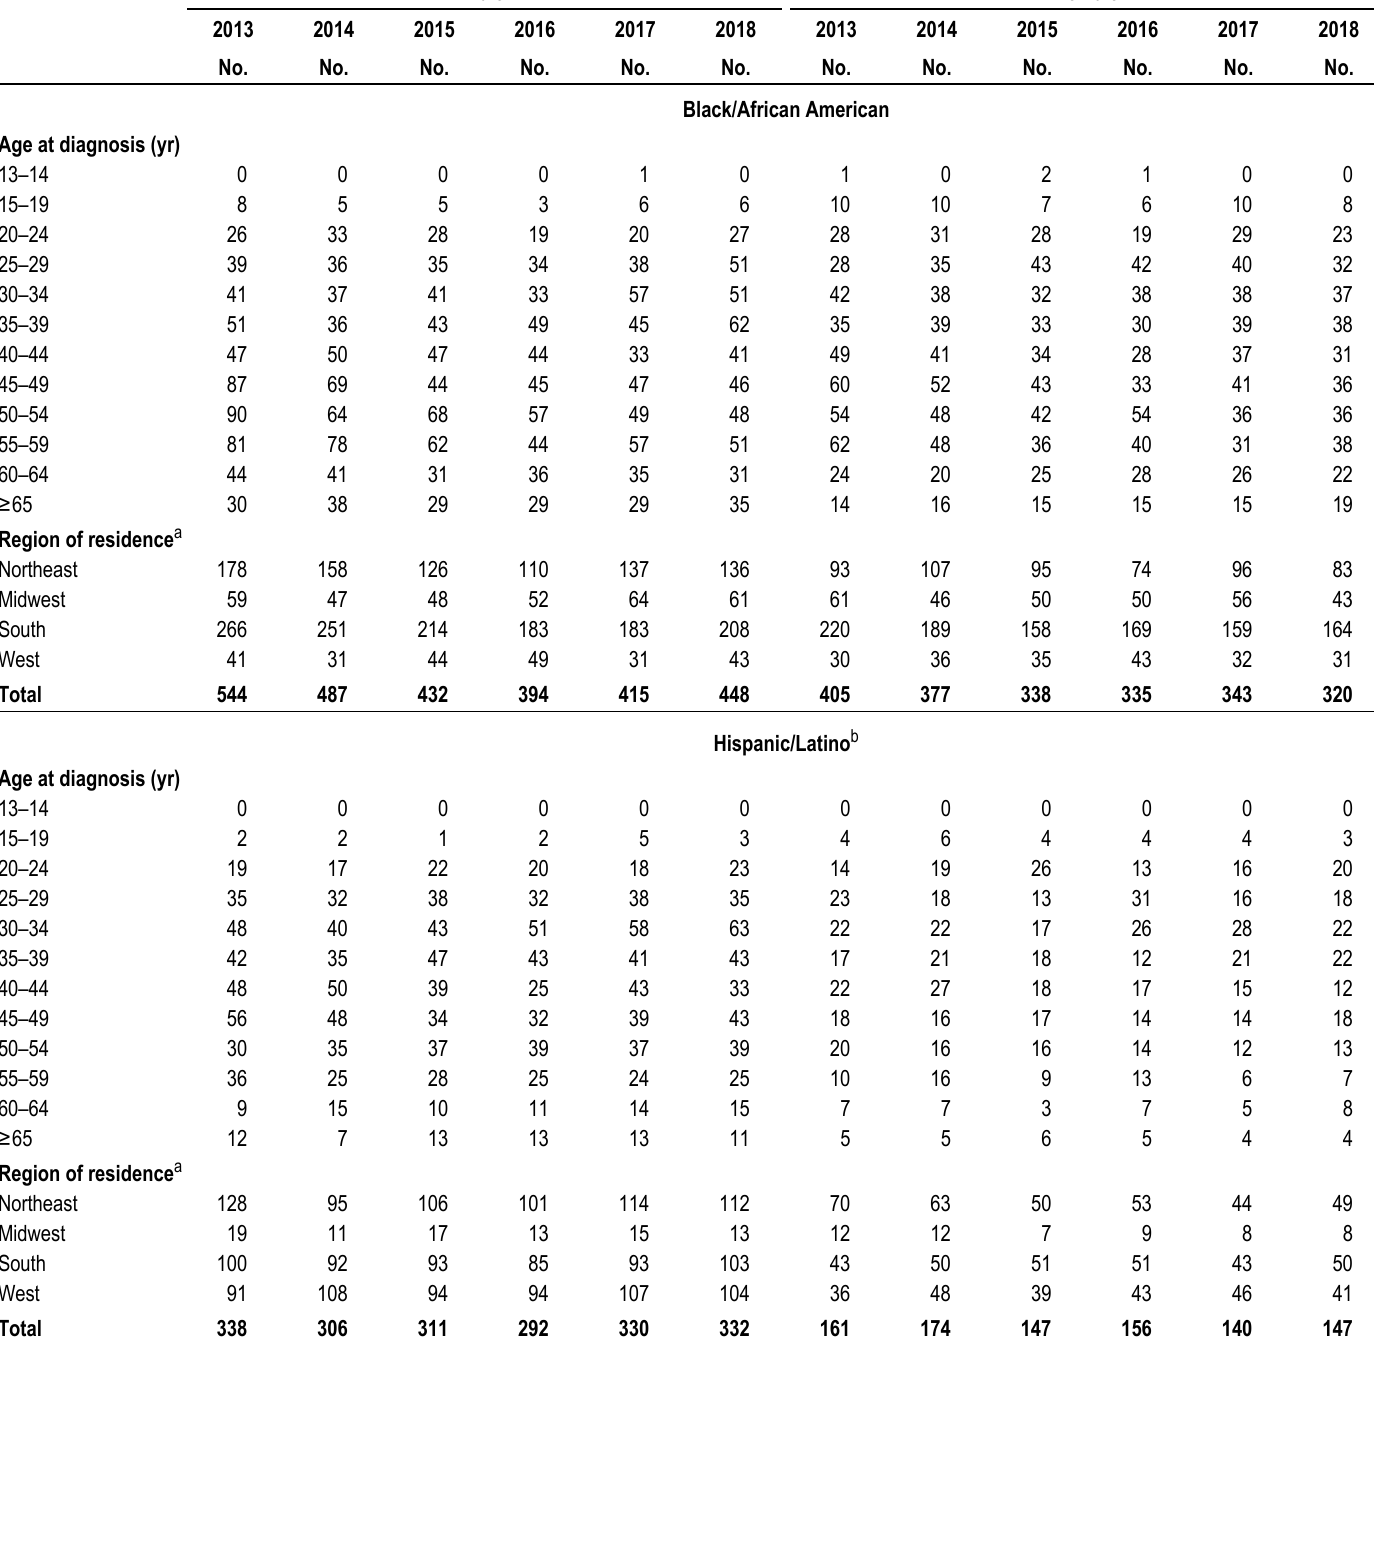
Table 8a. Diagnoses of HIV infection attributed to injection drug use, by selected characteristics, 2013–2018—United States (cont) Male